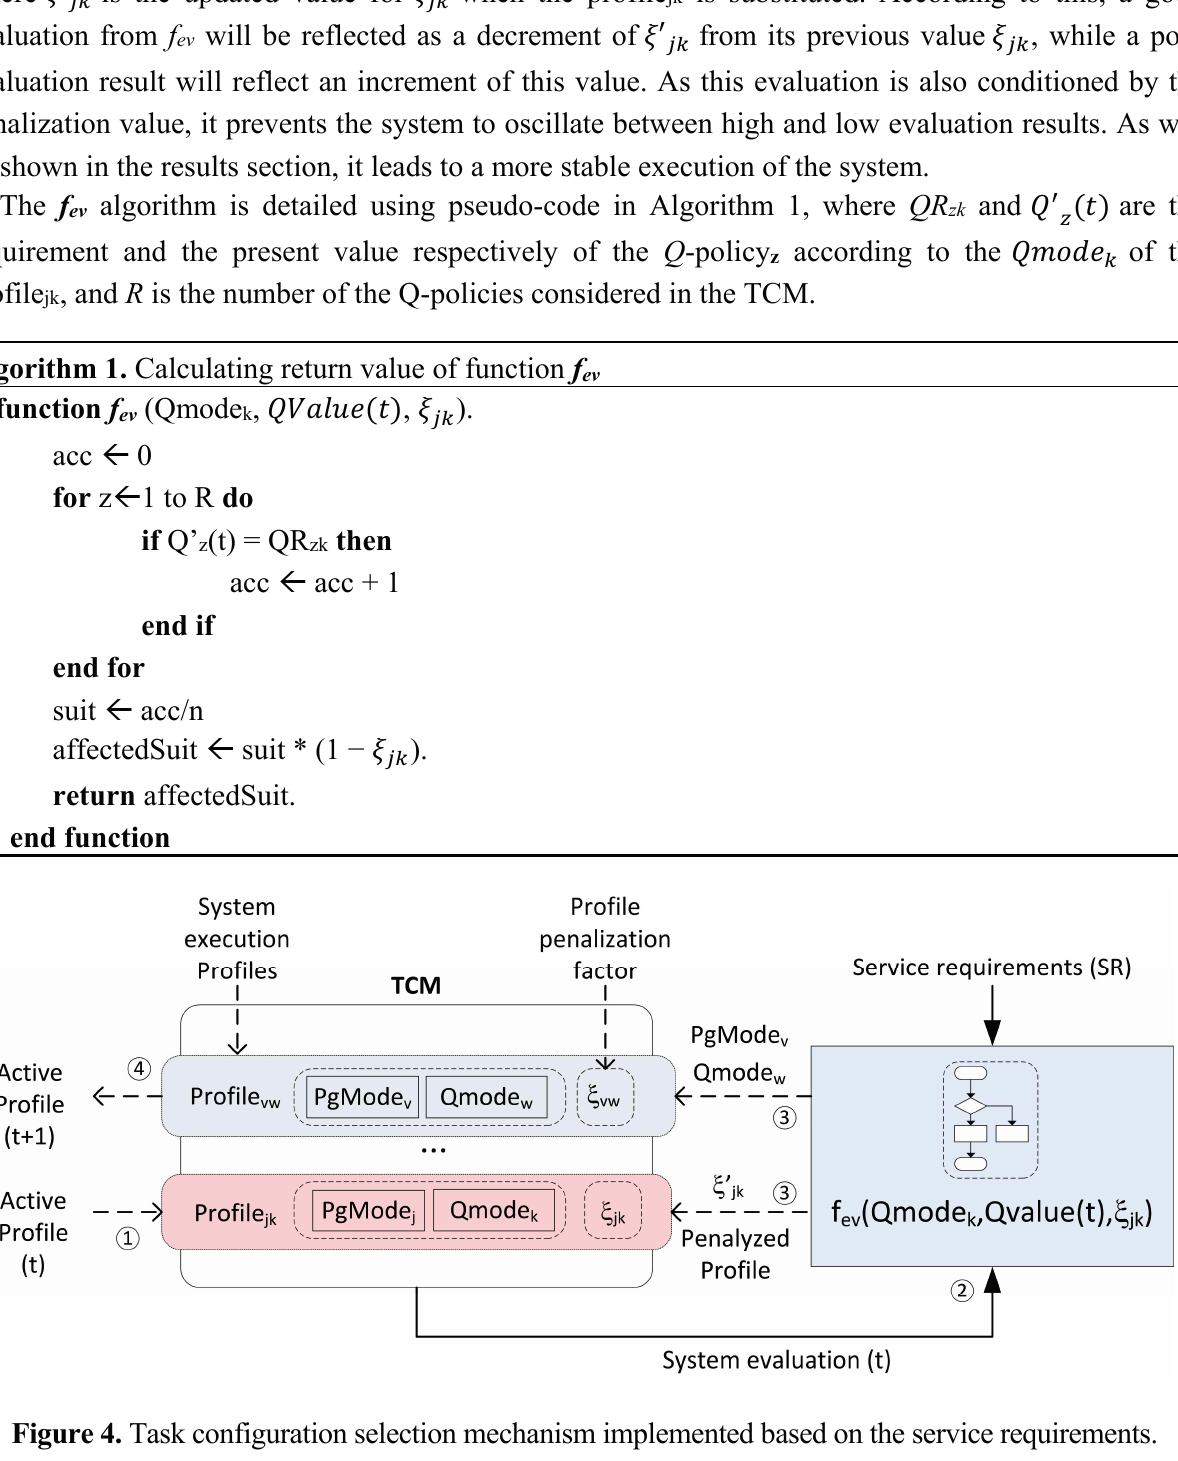
Figure 4. Task configuration selection mechanism implemented based on the service